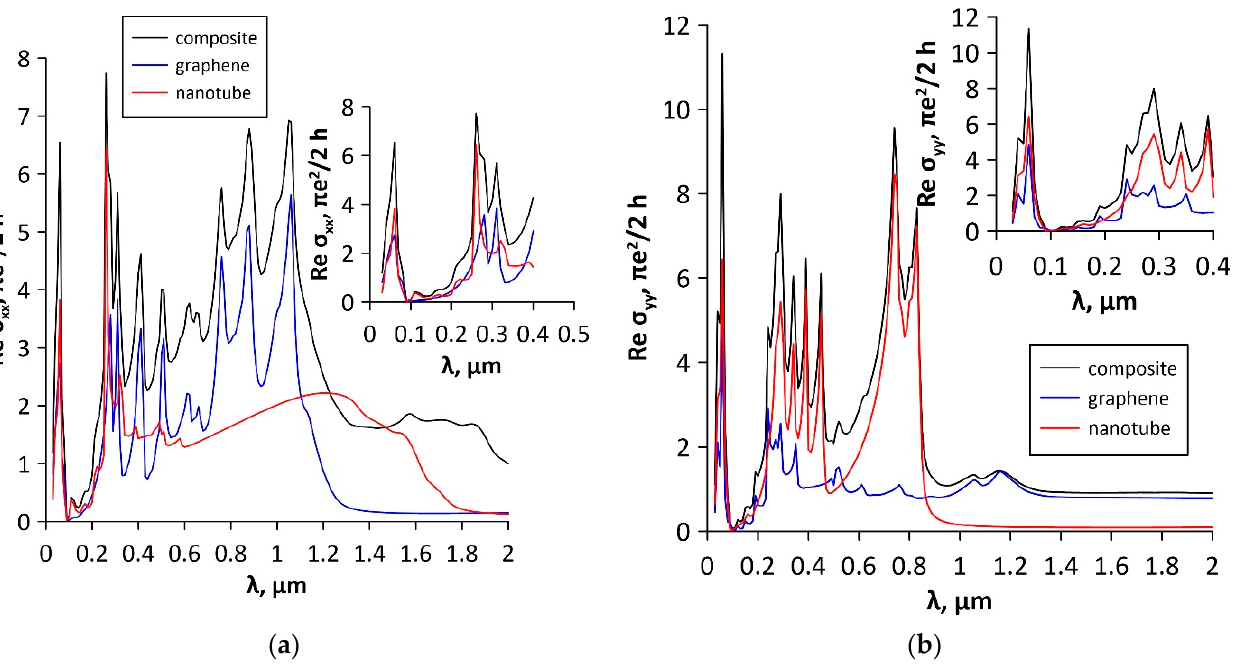
Figure 3. Profiles of the real part of the diagonal elements of the optical surface conductivity tensor for topological model V2 of a graphene-SWCNT (12,6) composite film: ( a ) with polarization along the X axis; ( b ) with polarization along the Y axis.